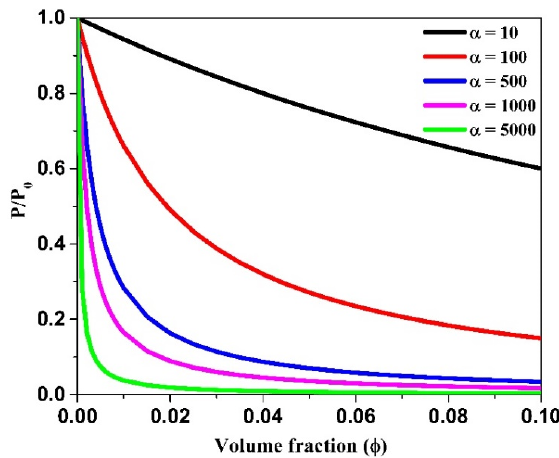
Figure 6. Prediction plot of Nielsen’s model at different aspect ratios.